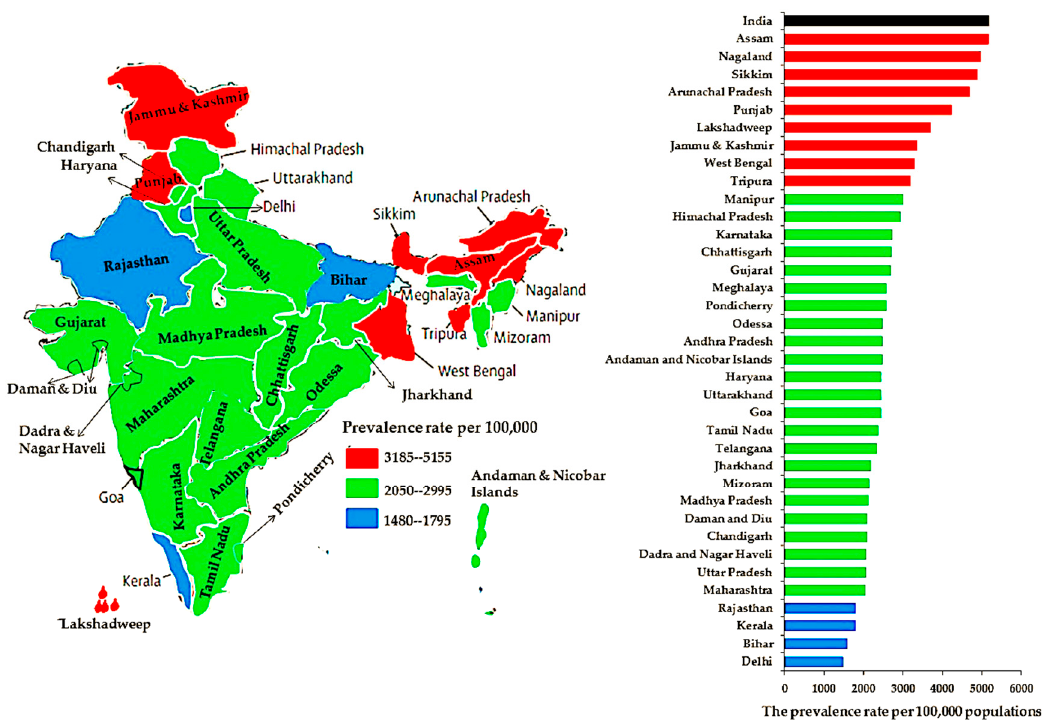
Figure 4. The prevalence rates of obesity among adults at the national level and per state and union territory.